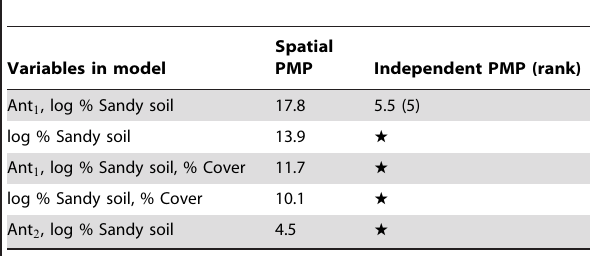
Table 3. Model selection results for the California lizard data set.